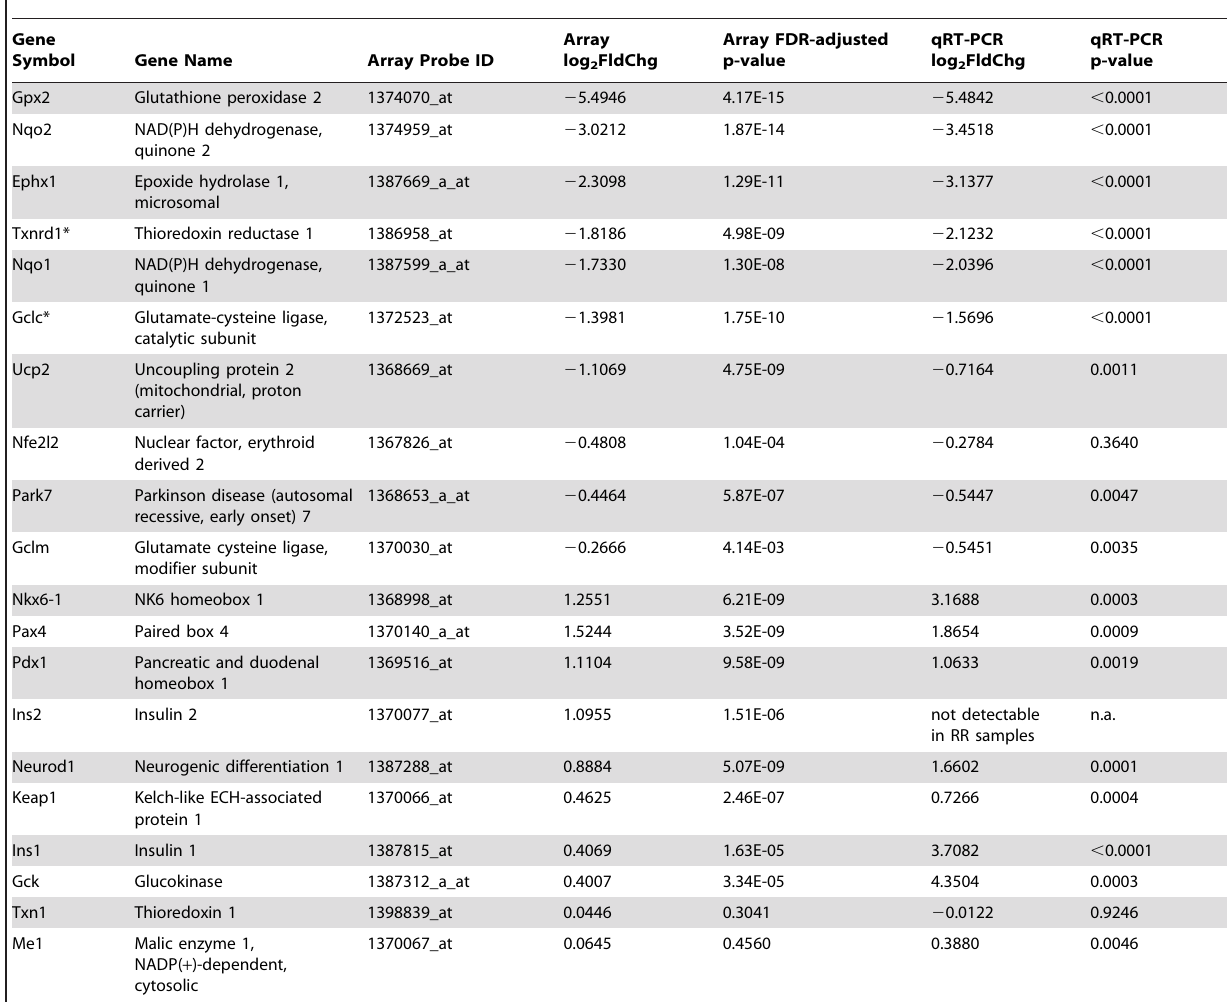
Table 1. qRT-PCR validation of microarray data for selected